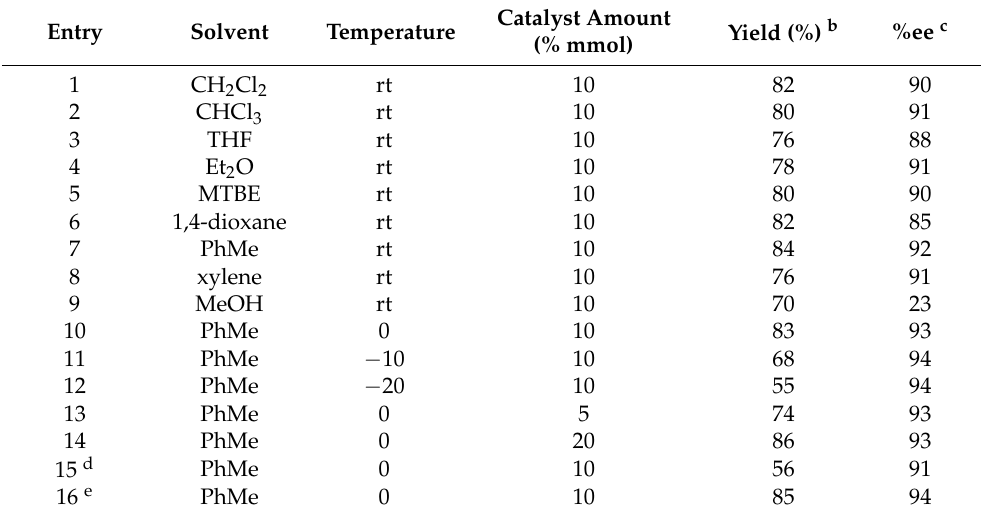
Table 2. Screening of reaction condition for the asymmetric Michael reaction catalyzed by 1c a . Catalyst Amount Entry Solvent Temperature Yield (%) b %ee c (% mmol) 1 CH 2 Cl 2 rt CHCl 3